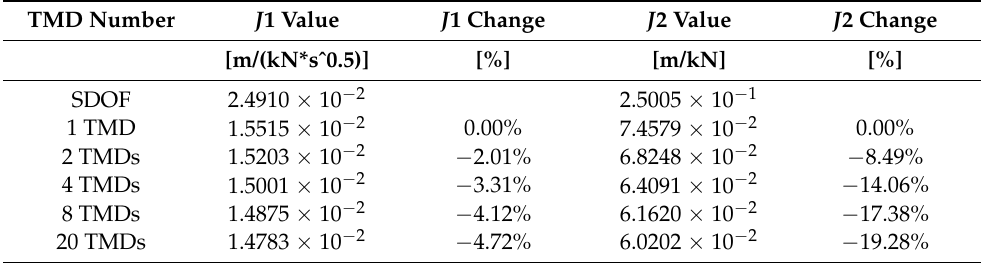
Table 2. The value of the J 1 and J 2 functions after completed optimization with the SA